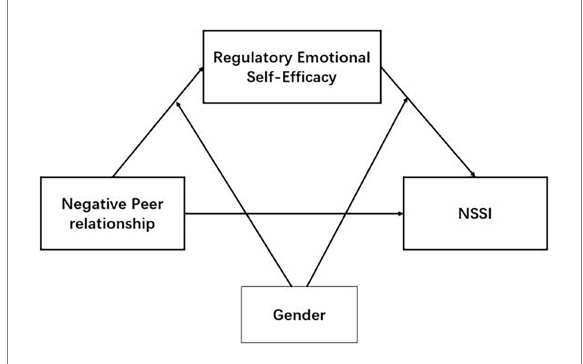
FIGURE 1 The proposed moderated-mediation model of the relationship between peer relationship and non-suicidal self-injury